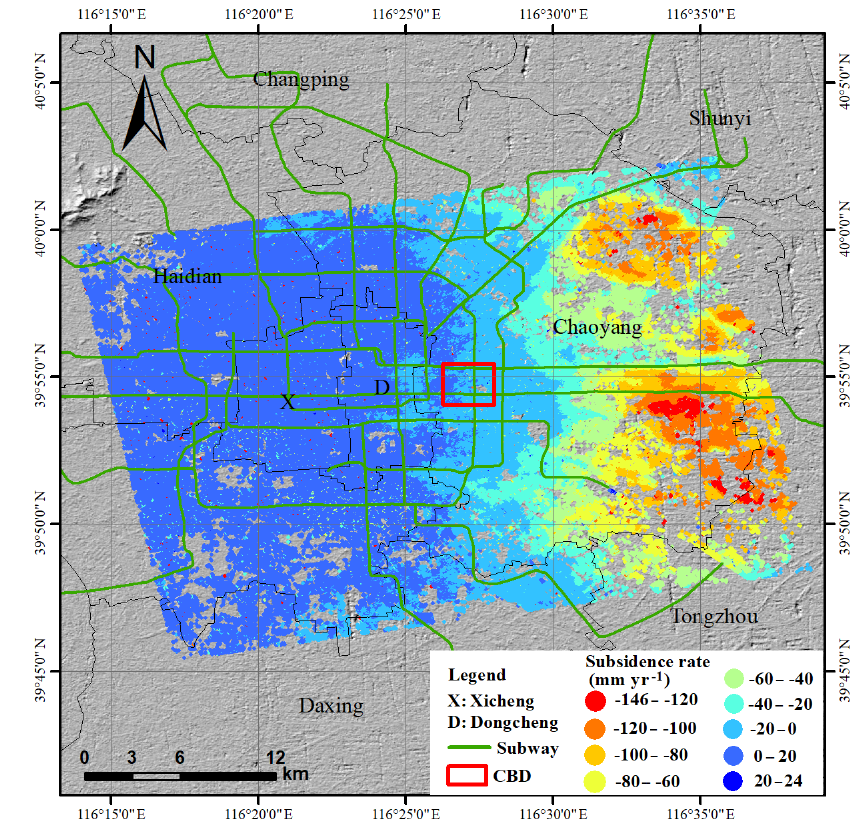
Figure 1. Land subsidence rate map derived from 68 TerraSAR-X images during observation periods between February 2010 and December